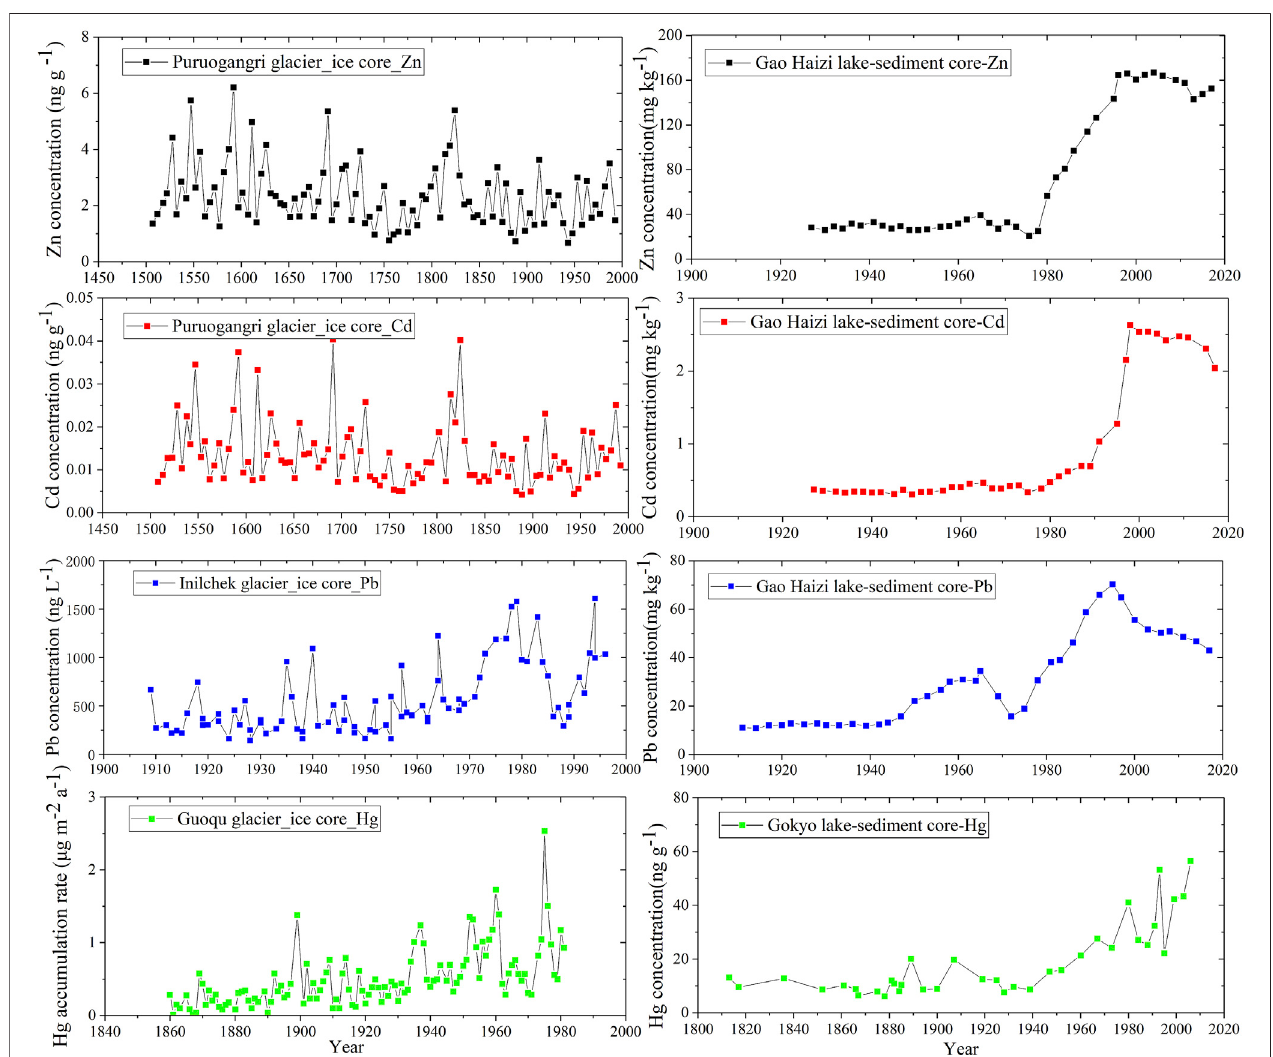
FIGURE5| HistoricaltrendsofHMsconcentrationsoraccumulationrateinicecoreandsedimentcorefromdifferentglaciersandlakes(Bingetal.,2016;Grigholm et al., 2016; Kang, et al., 2016b; Beaudon et al., 2017; Huang, et al., 2020b).